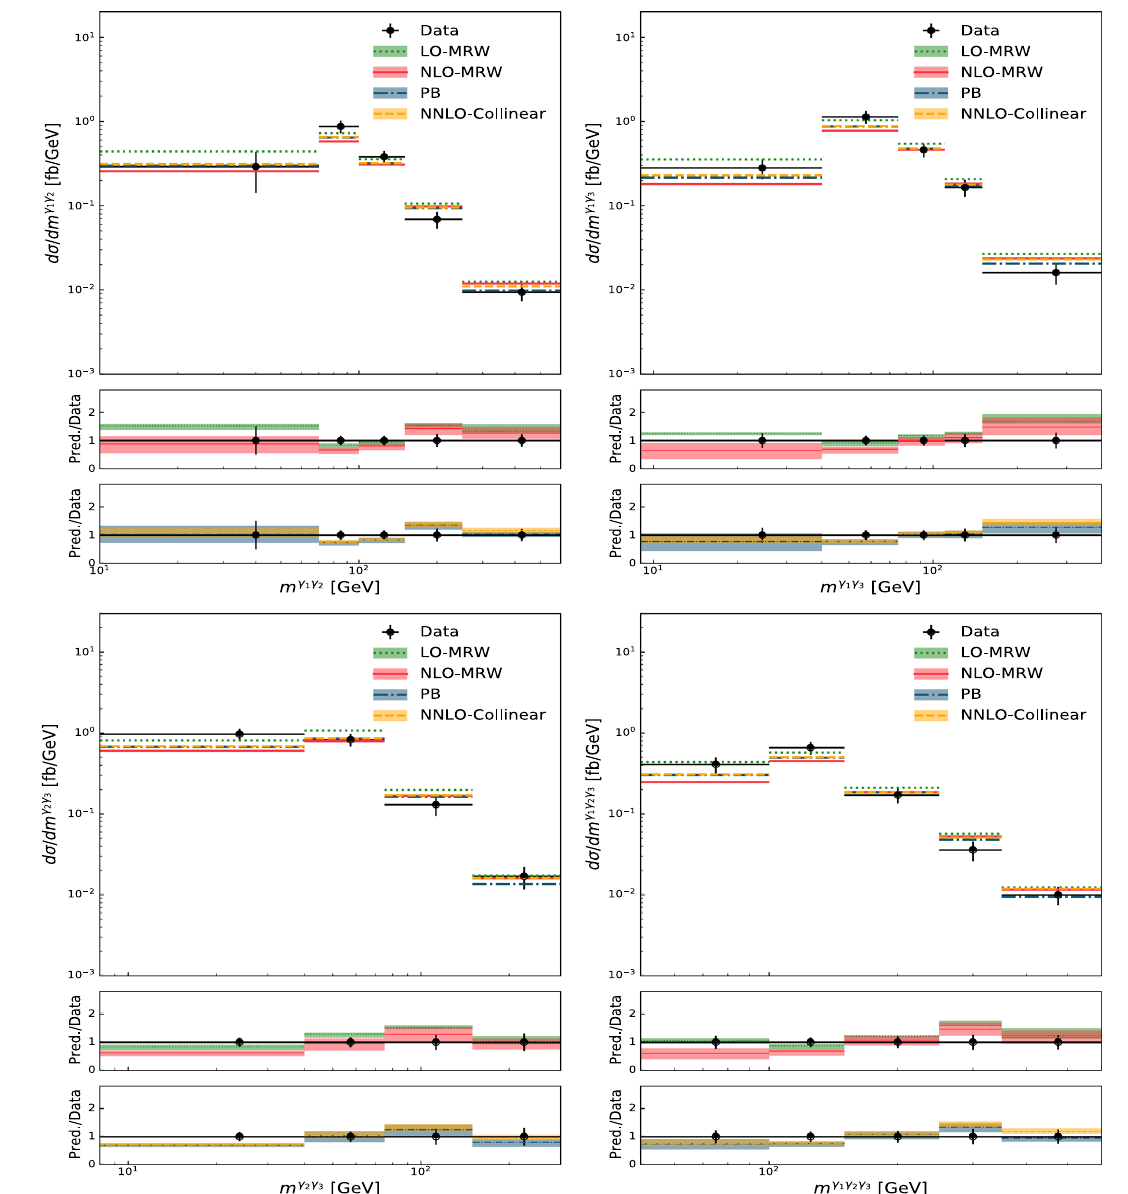
Fig. 9 The same as Fig. 7 but for invariant masses of different configuration of final state photon